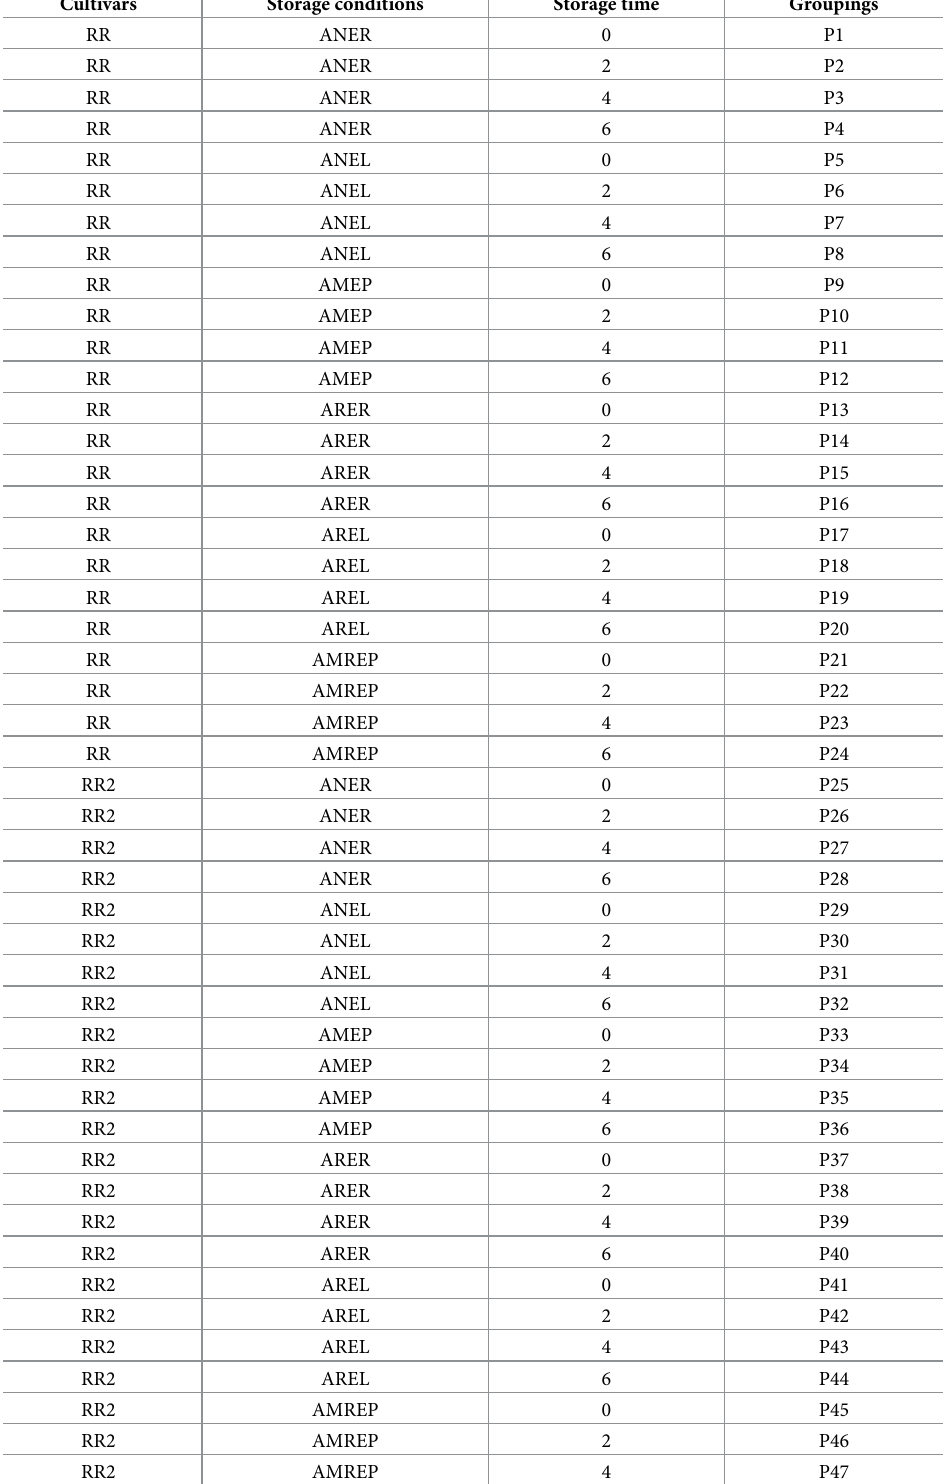
Table 1. Multivariate statistical analysis of soybean cultivars, conditions and storage